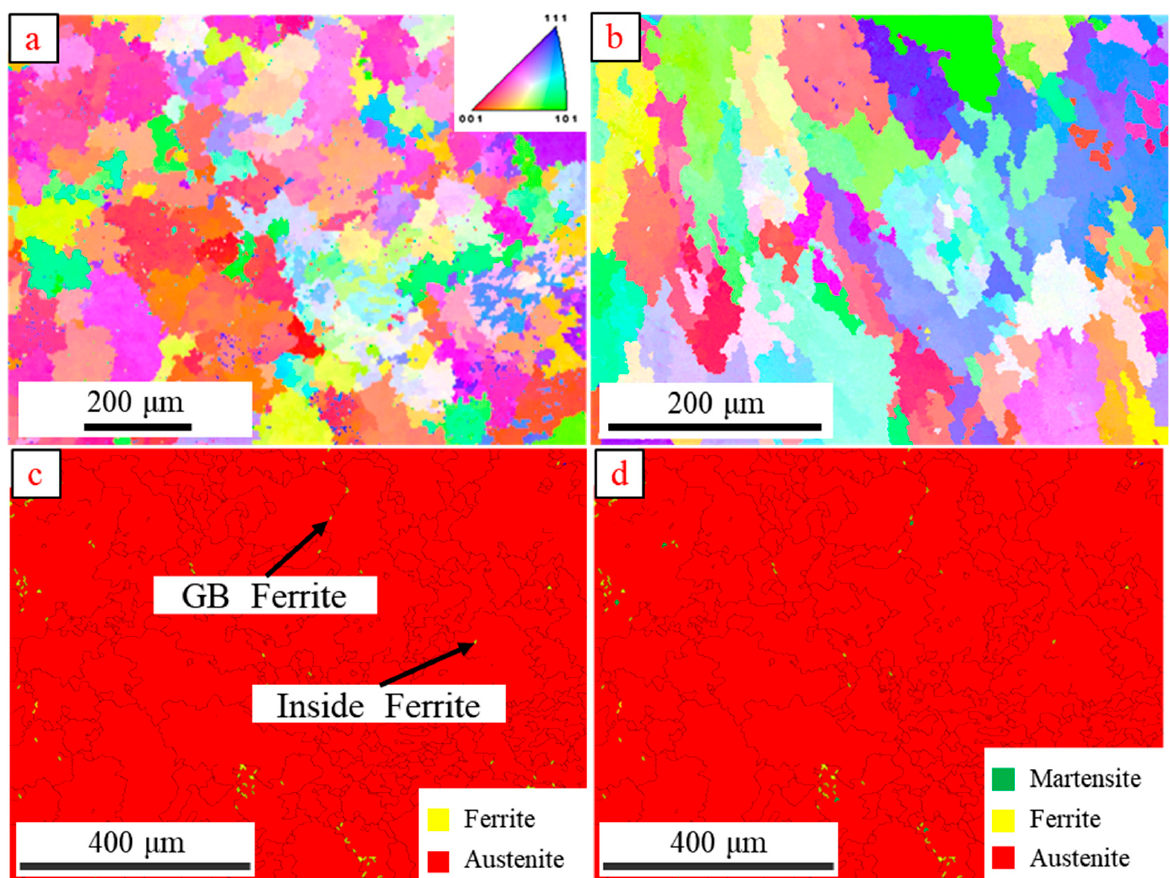
Figure 5. EBSD results of TIG weld before and after hydrogen charging (T8): ( a ) IPF of uncharged, ( b ) IPF of hydrogen-charged, ( c ) phase map of uncharged, ( d ) phase map of hydrogen-charged.